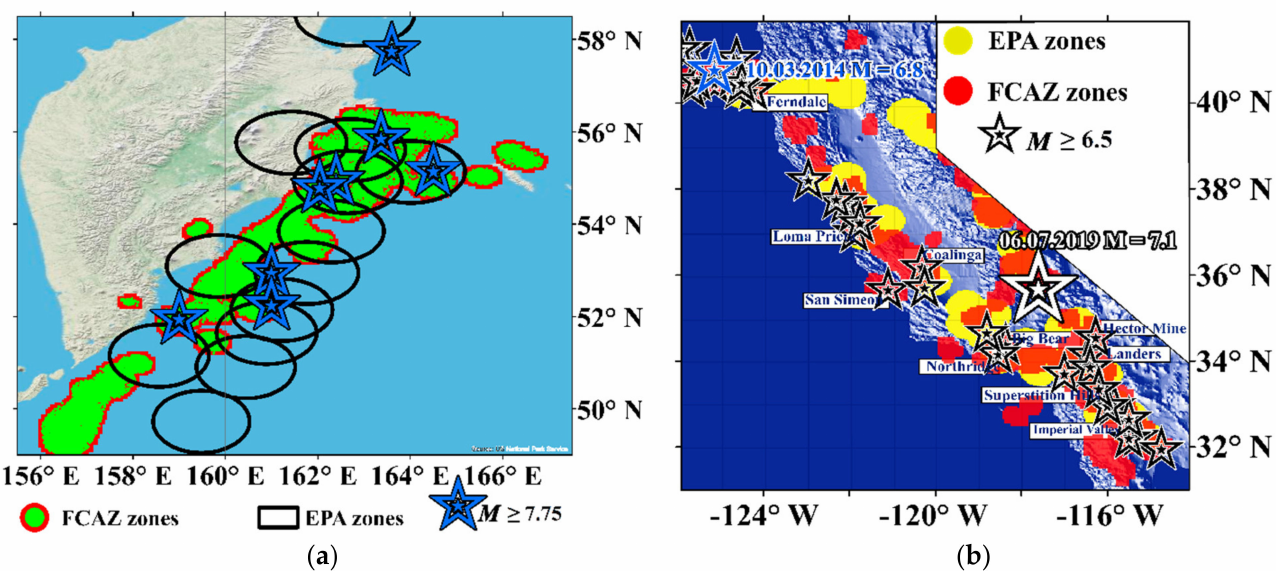
Figure 12. Comparison of the zones prone to earthquakes recognized by FCAZ and EPA methods: ( a ) Pacific Coast of the Kamchatka Peninsula; ( b )